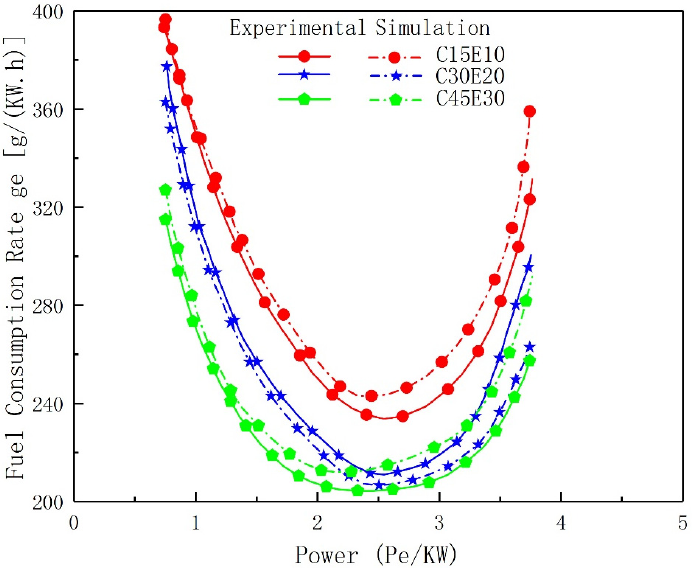
Figure 6. Comparison of the simulation and experimental results for the load characteristics of the swirl chamber diesel engine. Note: the rotation speed was 1200 r/min; the scheme numbers are the same as those in Table 1.